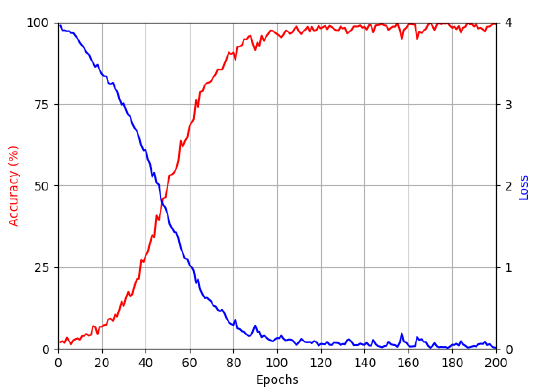
Figure 7. DEX training loss and accuracy graphs with enhanced images.